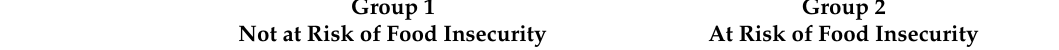
Table 2. Descriptive statistics of outcome, predictor, and moderating variables according to risk